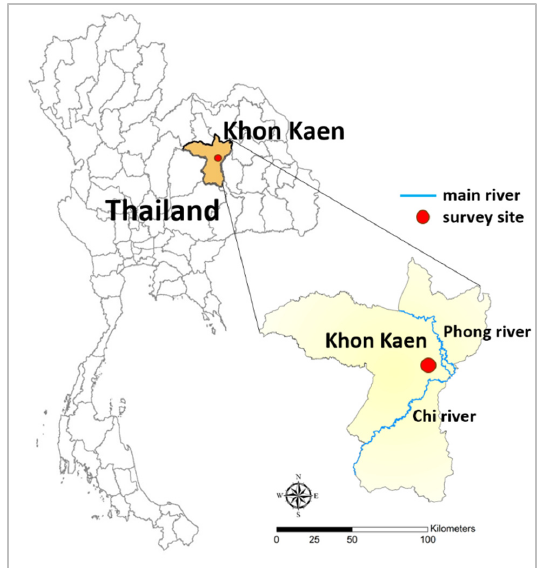
Figure 1. Location of the study area at Phra Lap sub-district, Mueang Khon Kaen district, Khon Kaen Province, northeastern Thailand .